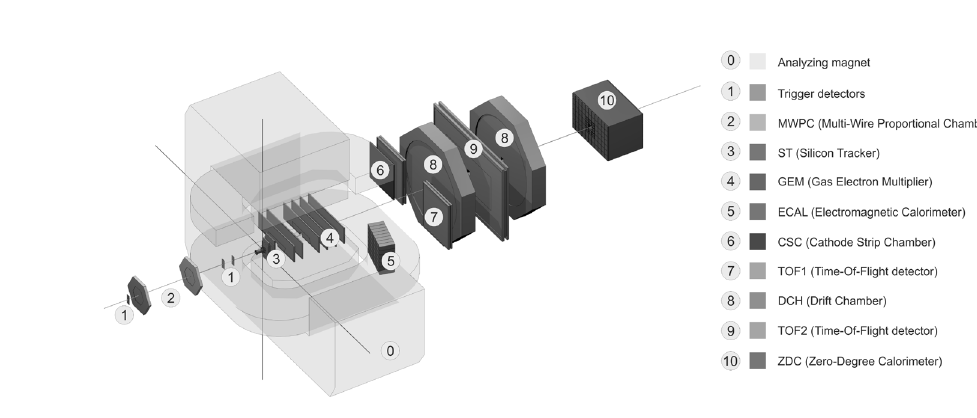
Figure 1. BM@N experimental setup for technical run on spring 2018